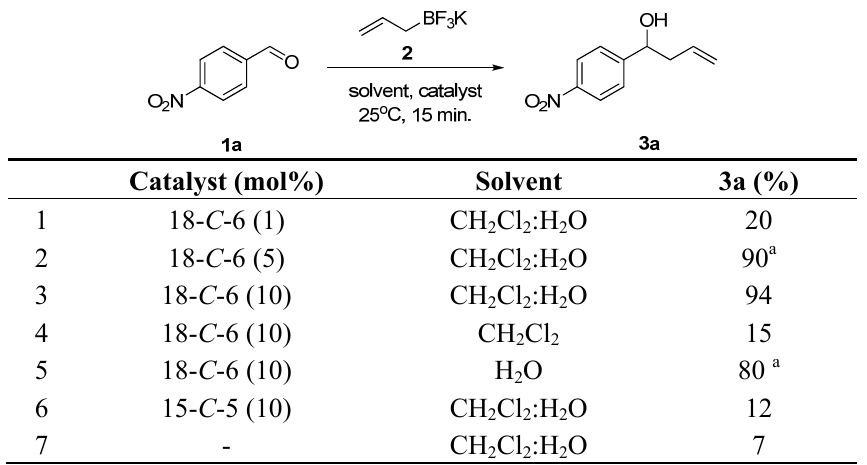
Table 1. Effect of solvent and catalyst on the allylation of 4-nitrobenzaldehyde ( 1a ) by potassium allyltrifluoroborate 2 .